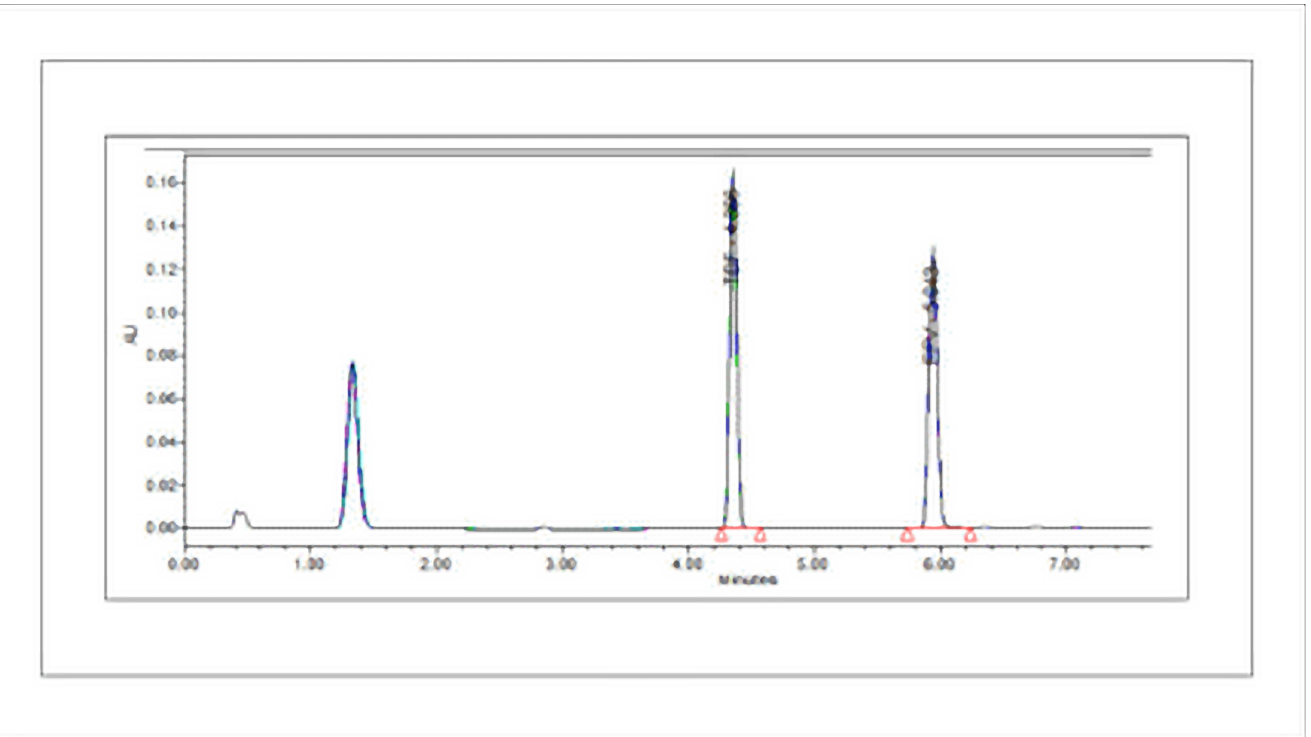
Fig 4. Chromatogram for precision